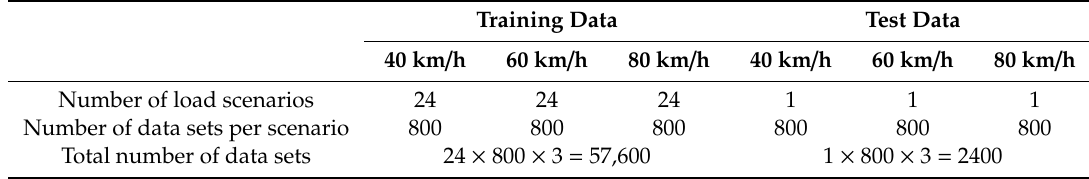
Figure 7. Measurement points on the girder (unit: mm). Table 2. Number of training and test data sets